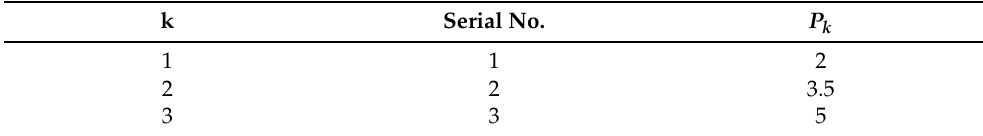
Table 1. Proposed Fast Estimation Results (example-1). k Serial No. P